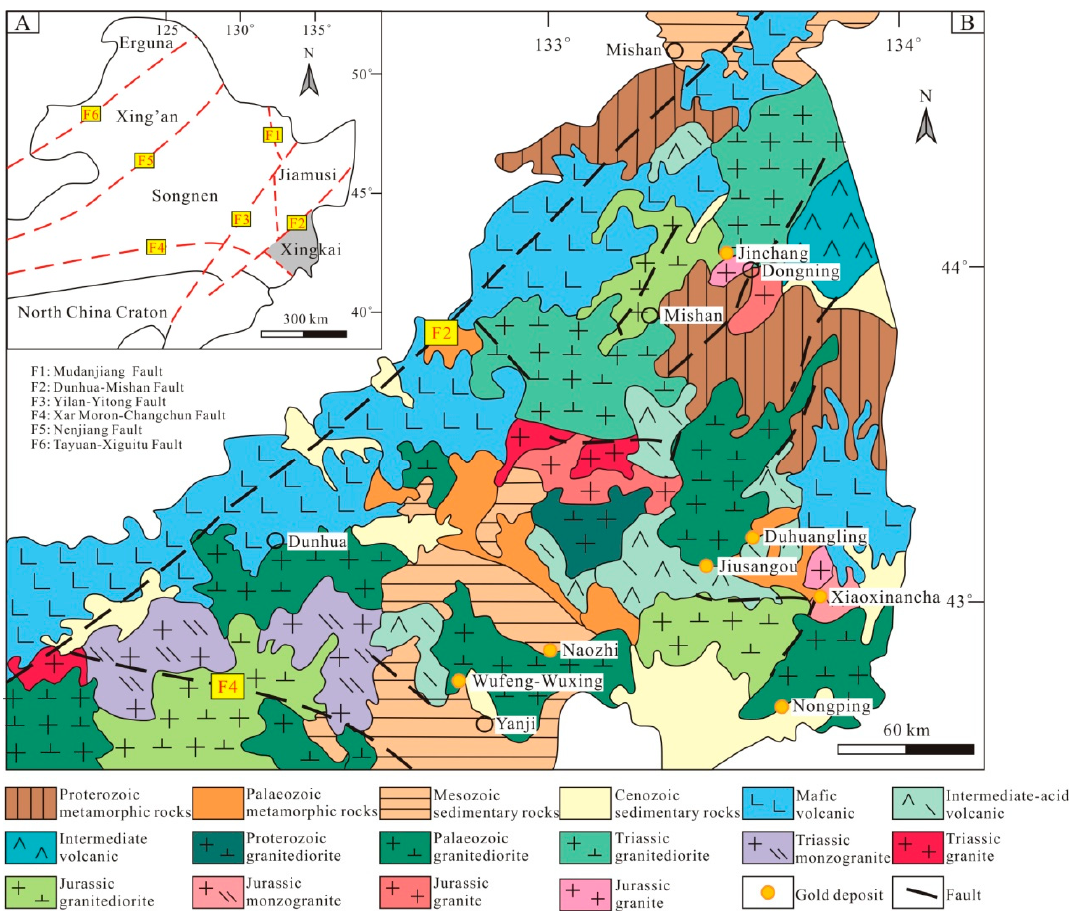
Figure 1. ( A ) Simplified tectonic map of Northeast China (modified after Wu et al. [17]). ( B ) Regional geological map of the Yanji–Dongning Metallogenic Belt, Northeast China (modified after Sun [18]), showing the location of the Jinchang gold deposit and other deposits discussed in this study.